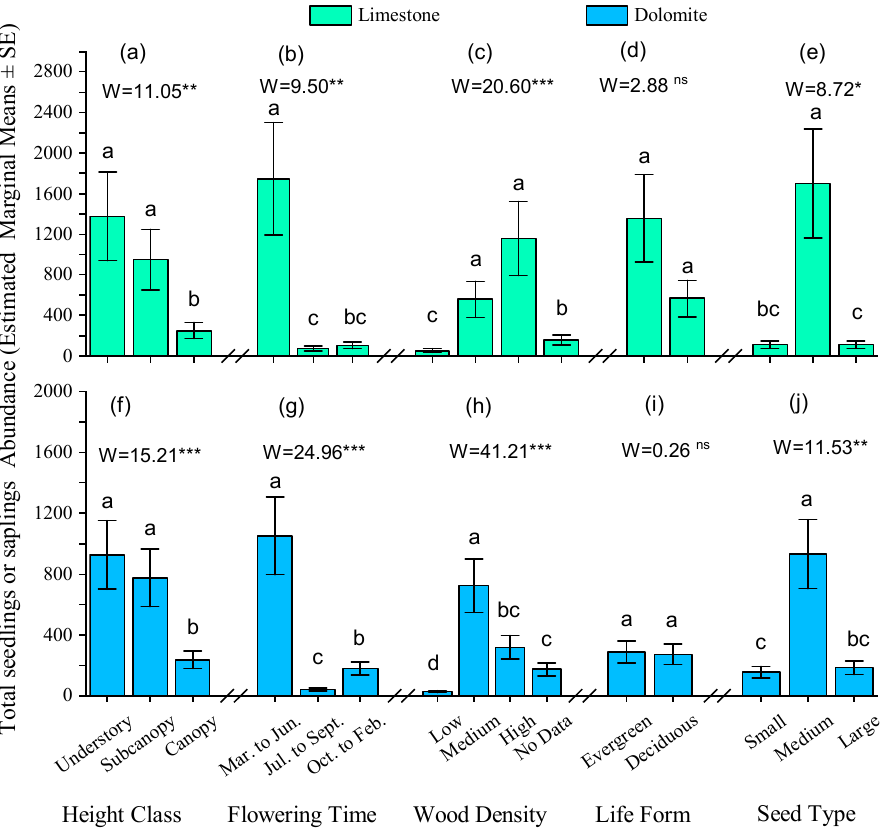
Figure 6. A comparison of the relative abundances of seedlings or saplings (all woody plants or shrubs DBH ≤ 3 cm) and their functional traits, ( a , f ) tree height class, ( b , g ) flowering time, ( c , h ) wood density, ( d , i ) life form and ( e , j ) seed type, from dolomite and limestone plots in Southwest China. Estimated marginal means among groups were computed from abundance data from the two karst sites using a negative binomial GLM (log link) with the Wald chi-square Stata (W). Each bar represents estimated marginal mean ± standard error of the mean. Bars with different letters stand for significant differences based on Bonferroni pairwise tests. The asterisks “***”, “**” and “*” represent the significance levels of 0.001, 0.01 and 0.05, respectively, and “ns” represents nonsignificant levels.